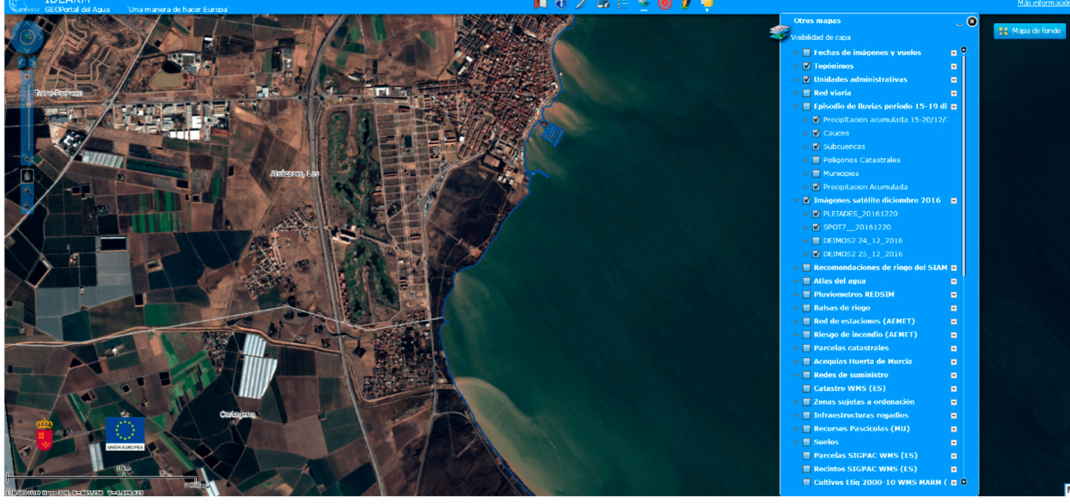
Figure 8. Initial screen (in Spanish) of the IMIDA